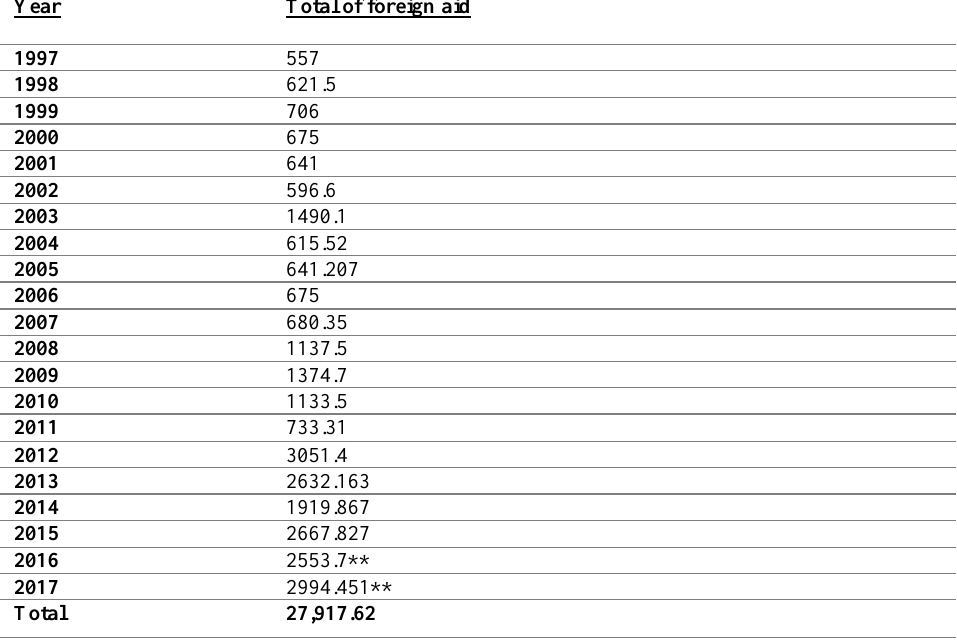
Table 1: Total of foreign aid to Jordan (1997 -2017) ($ US Million